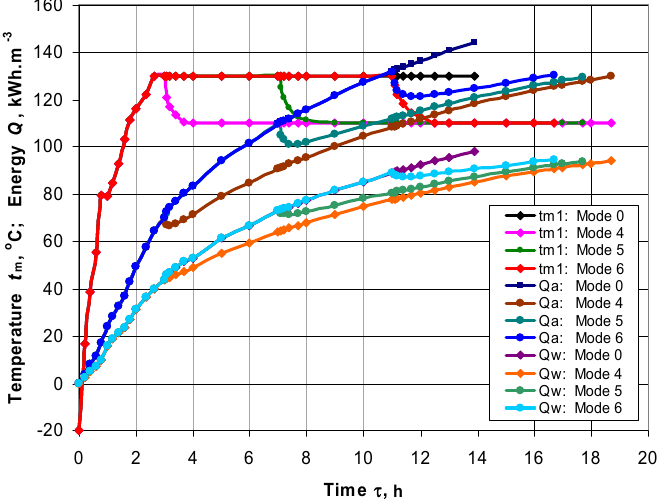
Figure 5. Changes in t m , Q a , and Q w during steaming modes 0, 4, 5, and 6, depending on τ .